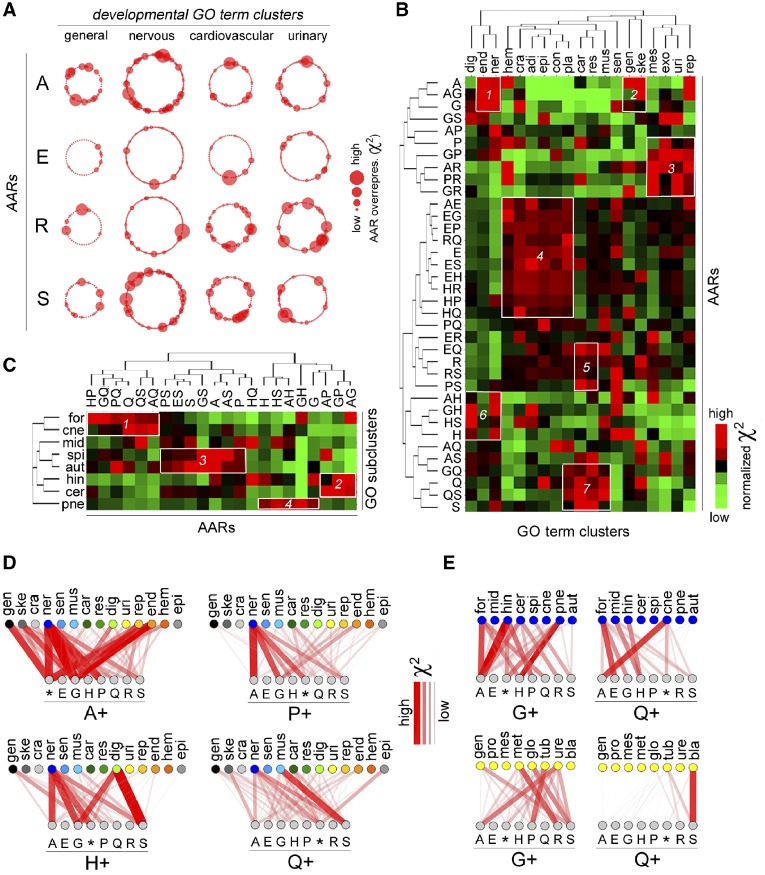
—Preferential combinatorial associations between AARs and DP functions. (A) Schematic representation of the overrepresentation of AAR-bearing proteins (A, E, R, and S AARs) in protein sets associated with developmental GO terms. Individual GO terms are represented by dots, grouped in four clusters (rings) associated with “general” or system-specific (“nervous,” “cardiovascular,” and “urinary”) developmental processes. The diameter of each dot is proportional to the AAR overrepresentation (χ2 value) in the set of proteins associated with the GO term. (B) Heat map of the association between AARs (rows) and proteins belonging to the 19 clusters (columns) involved in general (gen) or system/organ-specific developmental processes (e.g., nervous system, ner. Other abbreviations: adi, adipose tissue; car, cardiovascular system; con, connective tissue; cra, cranium; dig, digestive system; end, endocrine system; epi, epithelia/epidermis/adnexa; exo, exocrine glands; hem, hematopoietic/lymphatic systems; mes, mesenchyme/stem cells; mus, muscle; pla, placenta; rep, reproductive system; res, respiratory system; sen, sensory organs/systems; ske, skeleton; uri, urinary system). Each square represents normalized mean-centered χ2 value of each AAR/cluster association on a color scale where bright red represents highly significant associations and bright green non-significant associations. Black squares and those with darker shades of red and green represent intermediate levels of association. Note that black, in this normalized mean-centered heat map, represents intermediate levels of relative χ2 value in each cluster and not a threshold for statistical significance. For absolute χ2 values and statistical significance see Table S3. (C) Heat map of the association between AARs (columns) and proteins belonging to subclusters (rows) associated with the development of specific parts of the nervous system (e.g., forebrain, for). Each square represents the subcluster-normalized χ2 value of each AAR/subcluster association as in (B). Other abbreviations: aut, autonomous nervous system; cer, cerebellum; cne, cranial nerves; for, forebrain; hin, hindbrain; mid, midbrain; pne, peripheral nervous system; spi, spinal cord. (D and E) Graphs representing the strength of the statistical association between AAR combinations and developmental GO term clusters (D) or subclusters (E). The thickness of the lines connecting the nodes is proportional to the χ2 value of each association. The upper rows indicate GO term (sub)clusters. The lower rows indicate the combinations of a given AAR, indicated below the horizontal line (e.g., A+), with the other AARs indicated above. The asterisk indicates the overall set of proteins with a given AAR (e.g., A+* indicates polyA proteins overall, irrespective of their combination with other AARs). Cluster and subcluster abbreviations as in (B and C). Other abbreviations: bla, bladder; cel, cellular processes; clo, cloaca; gen, urinary system in general; glo, glomeruli; mes, mesonephros; met, metanephros; pro, pronephros; tub, tubules; ure, ureter.